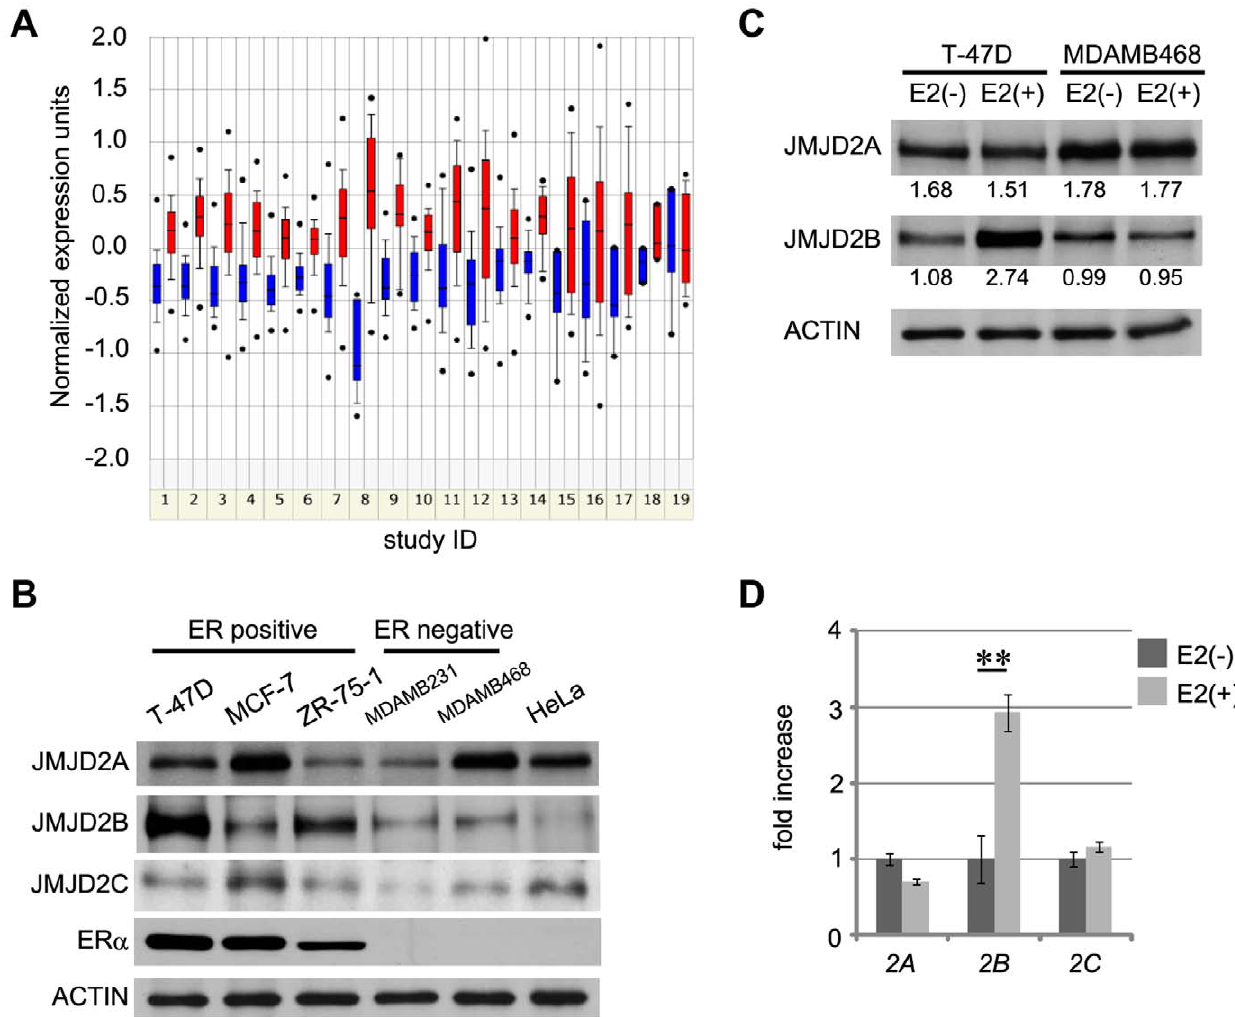
Figure 1. Elevated expression of JMJD2B in ER-positive breast cancers. (A) JMJD2B mRNA expression in clinical breast cancer samples from 19 studies registered in the ONCOMINE database. Blue bars, JMJD2B mRNA in ER-negative samples; red bars, JMJD2B mRNA in ER-positive samples. Data were analyzed using ONCOMINE algorithms. mRNA expression levels are represented by normalized units. The line within each colored box represents the median value for each group, and the upper and lower edges of each box indicate the 75th and 25th percentiles, respectively. Study details and statistical values are described in Table S1. (B) JMJD2B protein levels are higher in ER-positive breast cancer cell lines. Extracts of ER- positive and ER-negative breast cancer cell lines were analyzed by western blot to detect JMJD2 family members. Actin, loading control. (C) JMJD2B protein expression is induced by E2 stimulation. T-47D cells (ER-positive) and MDA-MB468 cells (ER-negative) were cultured in steroid-depleted serum for 4 days and stimulated with or without E2 for 24 hr. Cell extracts were analyzed by western blot. Relative intensity of the JMJD2A and JMJD2B bands are shown. The values are normalized to the bands of corresponding actin. (D) E2 stimulates JMJD2B expression. T-47D cells were cultured in steroid-depleted serum for 4 days followed by E2 stimulation for 6 hr. JMJD2A , JMJD2B and JMJD2C transcript levels are shown relative to levels in untreated controls (set to a value of 1). Expression levels were normalized to ACTB expression levels. Data represent mean 6 s.d. of triplicates. ** p , 0.01. Full-length blots are presented in Figure